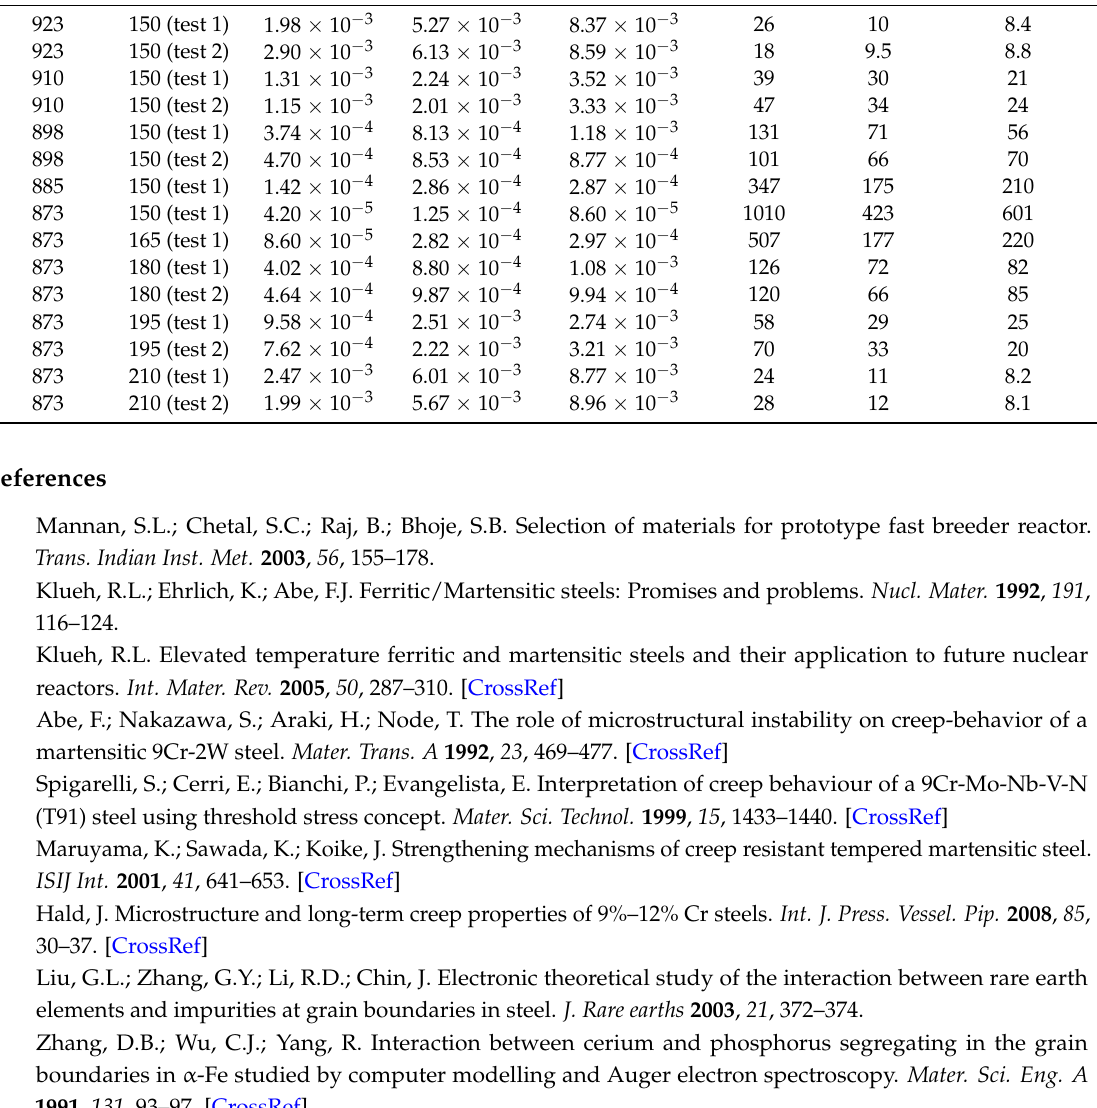
Table A1. Minimum creep rate and rupture time for the undoped, Sb-doped, and Sb+Ce-doped specimens tested at various engineering stresses and temperatures.